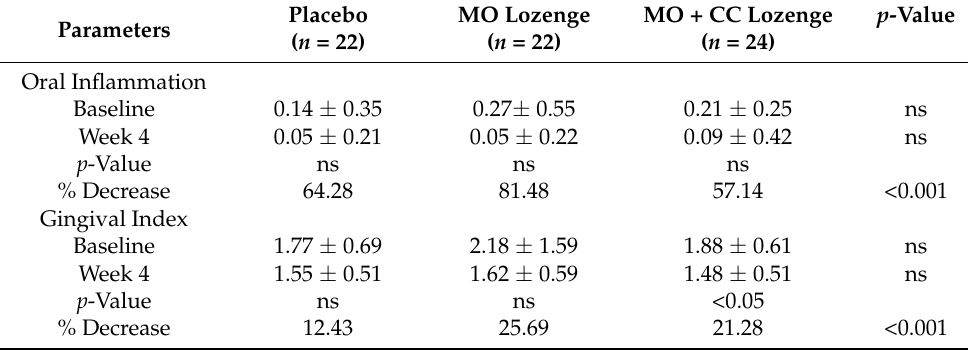
Table 5. Gingival index and oral inflammation smokers in placebo, MO lozenge, and MO + CC lozenge groups. The different of oral inflammation and gingival index among three groups were analyzed using Kruskal–Wallis test. The values between baseline and week 4 was analyzed by Wilcoxon signed rank test at the p < 0.05 level. The values were represented as mean ± SD, ns is not significant. MO: Moringa oleifera ; CC: Cyanthillium cinereum .